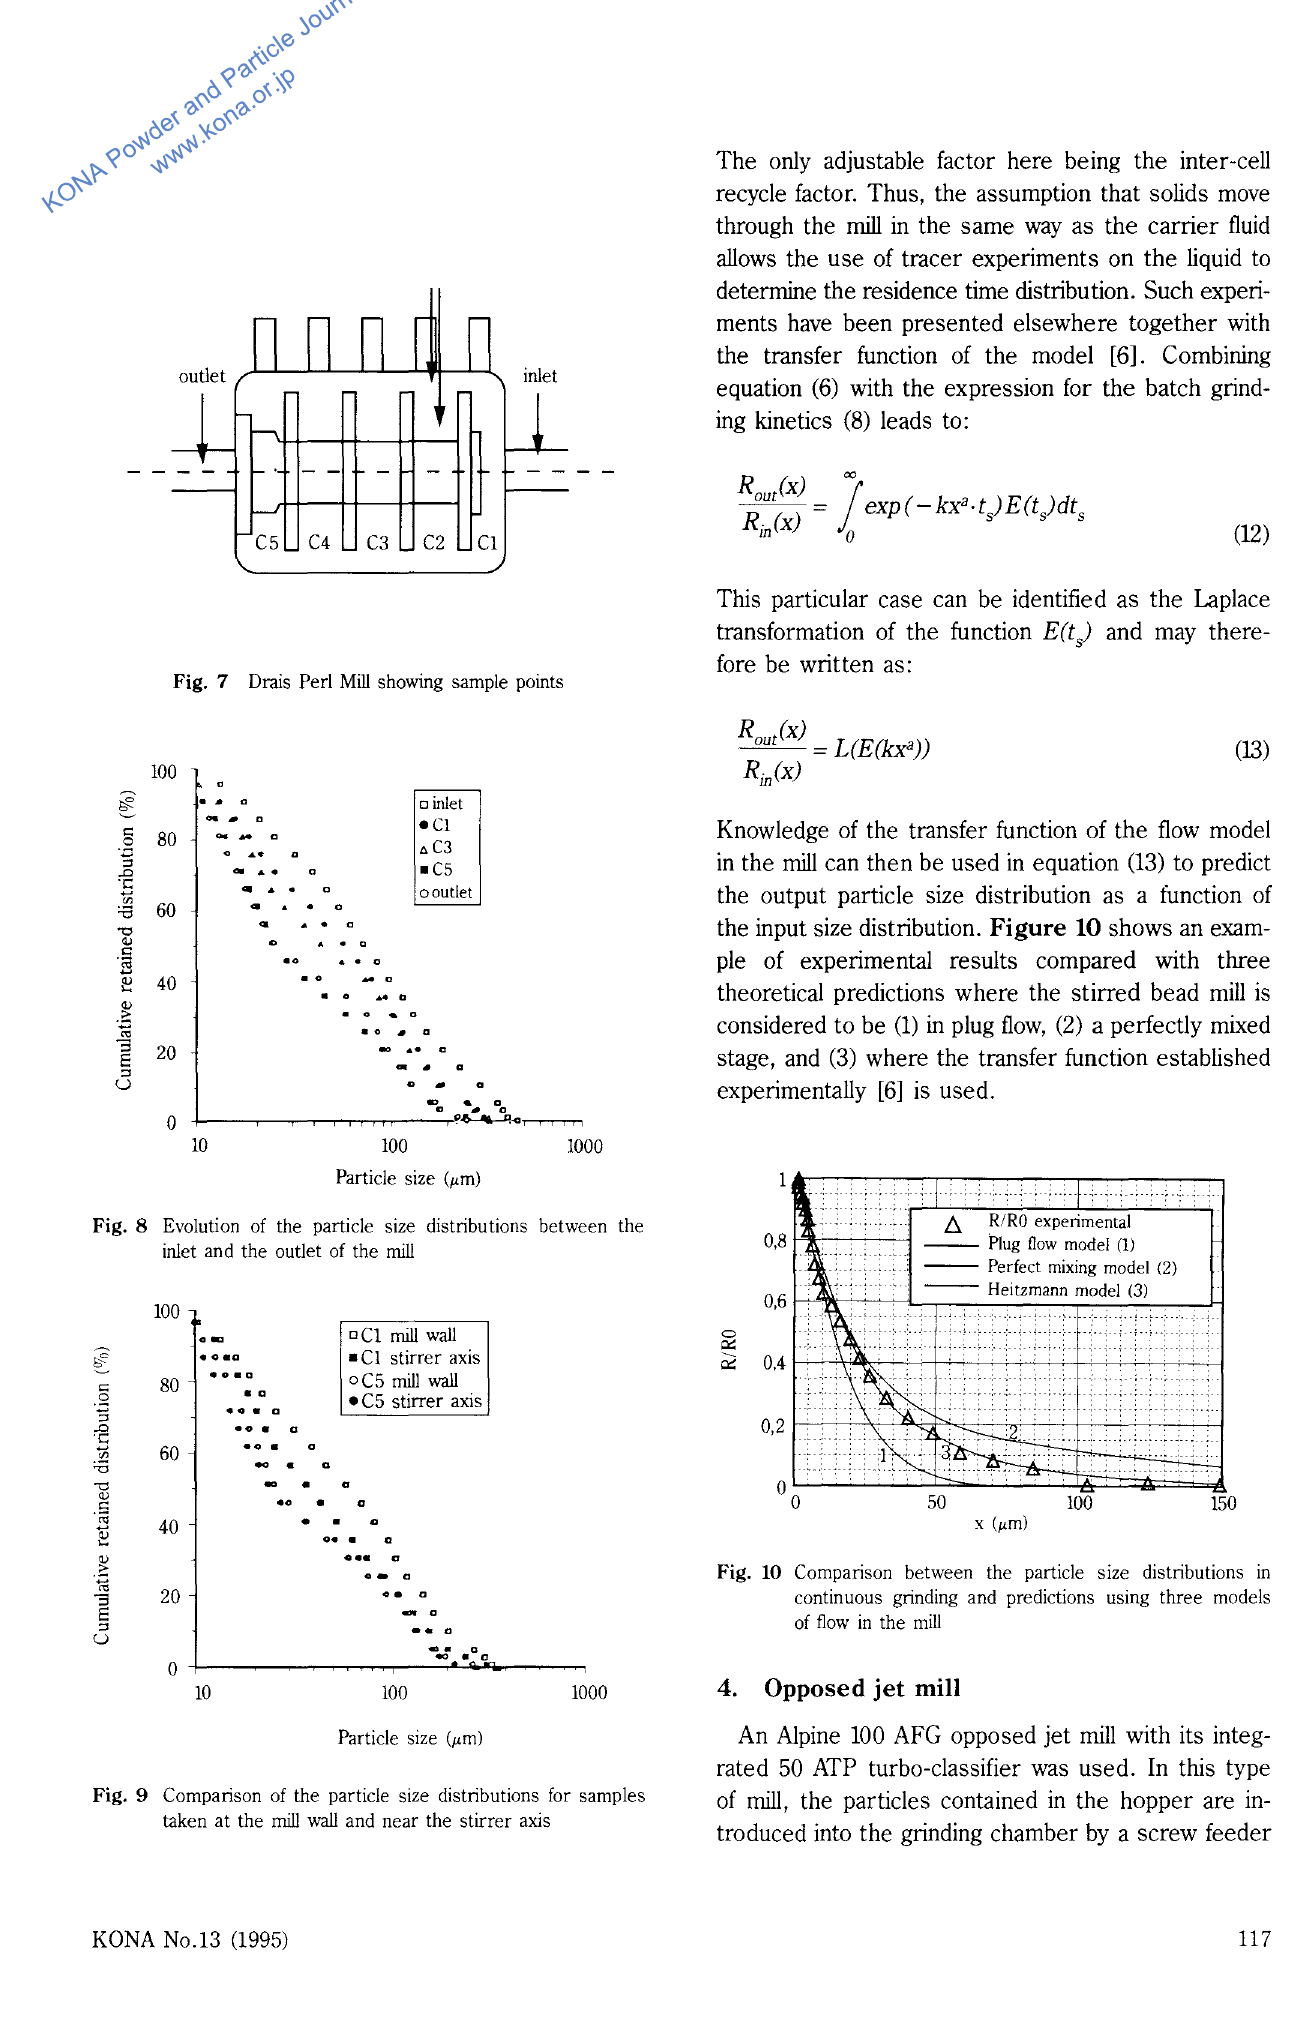
Fig. 9 Comparison of the particle size distributions for samples taken at the mill wall and near the stirrer axis